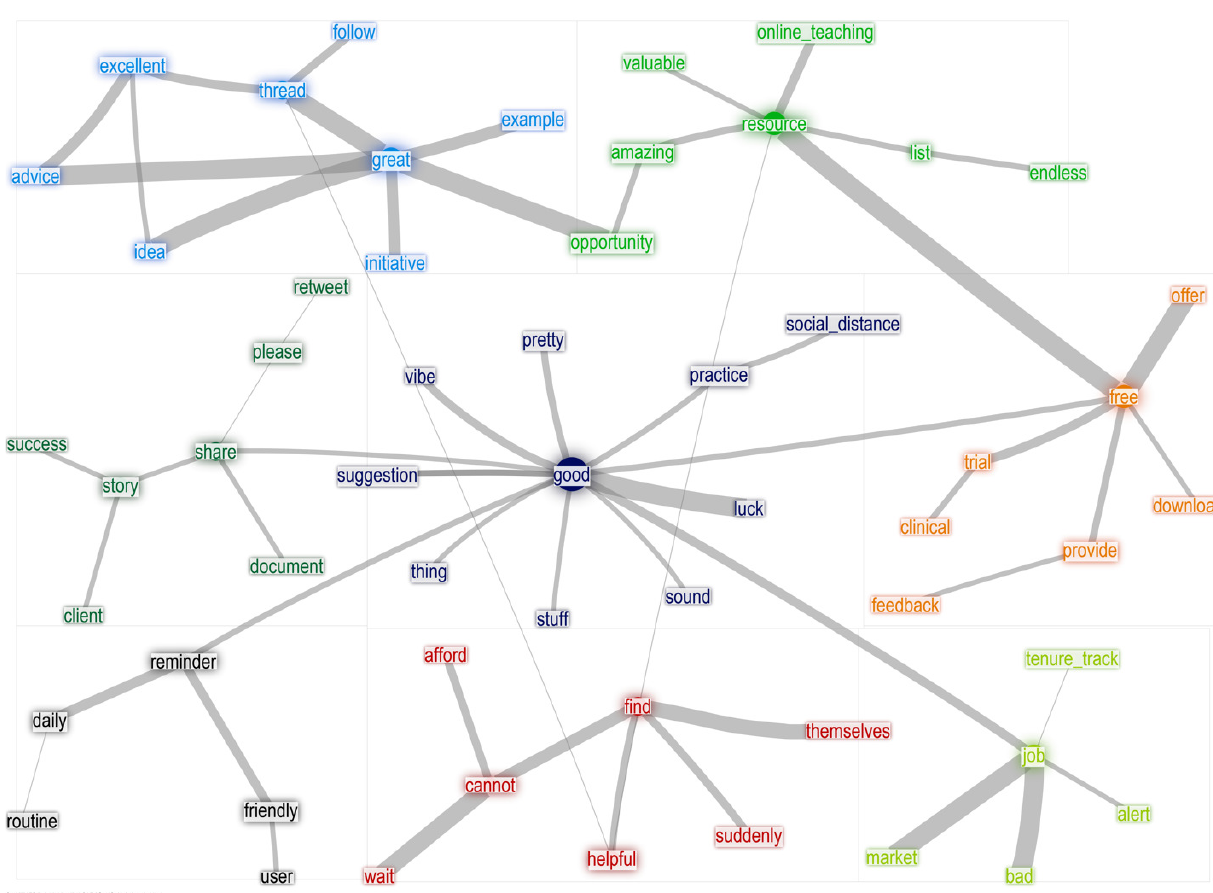
Figure 2. Discussions around knowledge sharing within